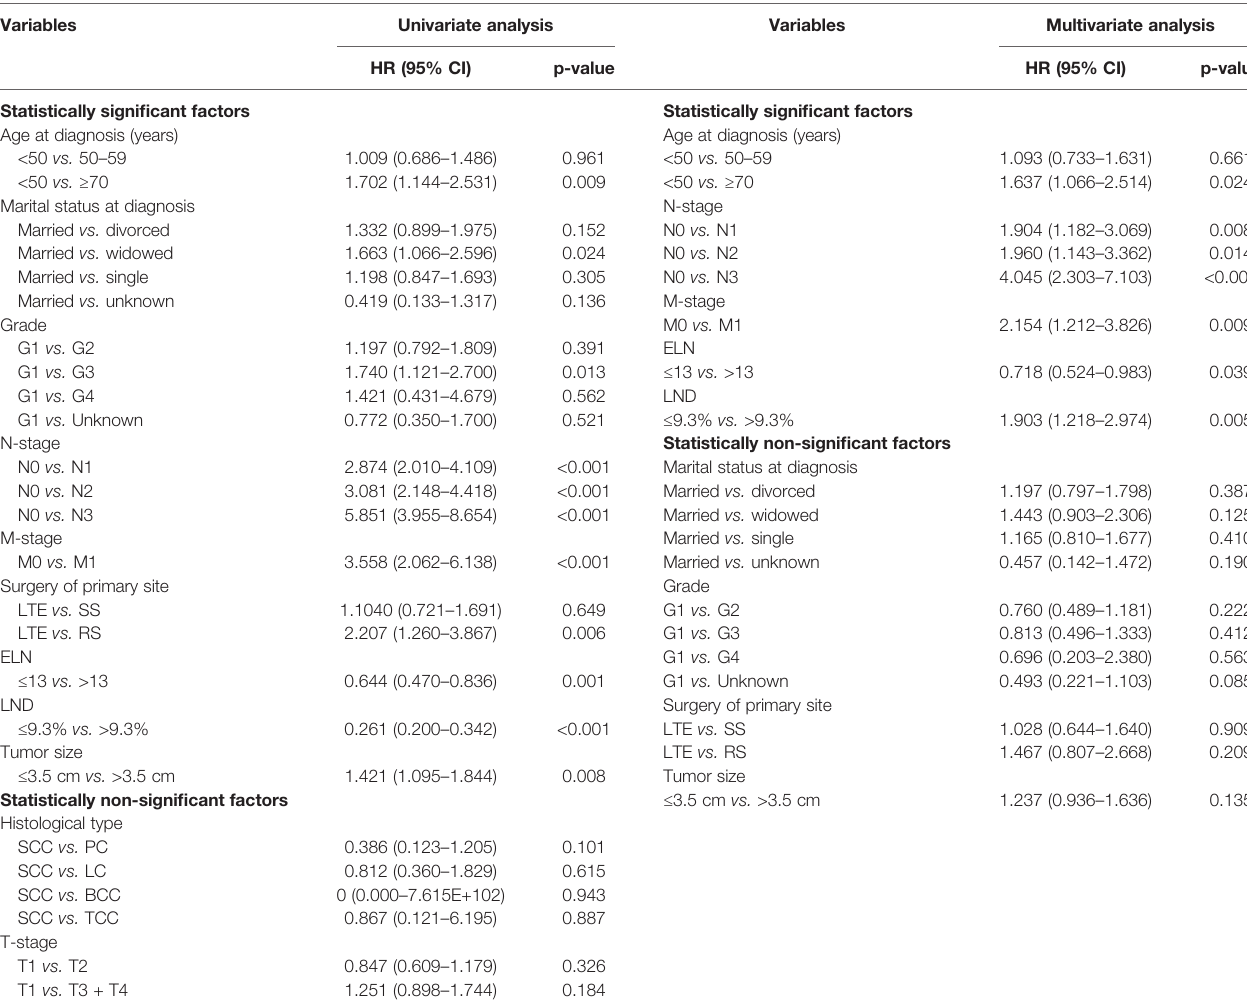
FIGURE 3 | Mosaic plot. (A) Distribution and relationship of LND, T-stage, N-stage and M-stage. (B) Distribution and relationship of LND, tumor grade, and tumor size. LND, Lymph node density. TABLE 3 | Univariate and multivariate analysis of the training